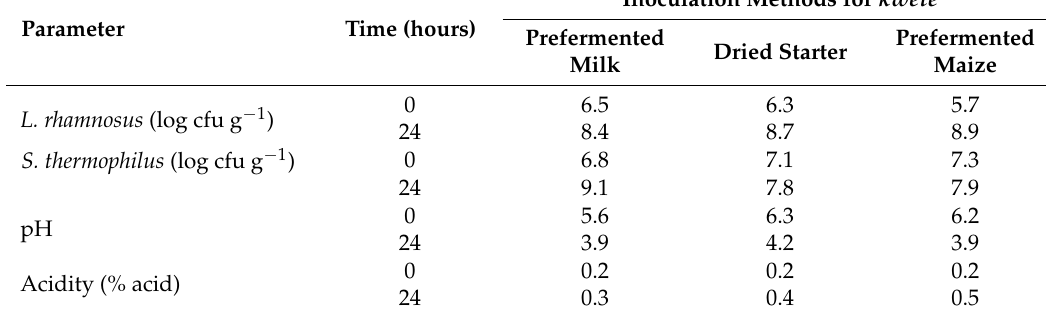
Table 2. Comparison of inoculation methods for initiating the fermentation of kwete with L. rhamnosus yoba 2012 and S. thermphilus C106. Values are means of two independent fermentations (no variations